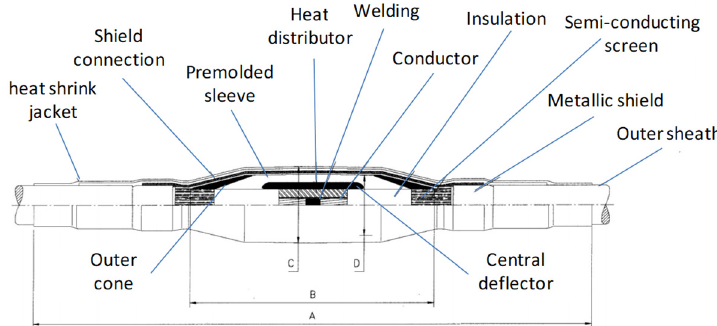
Figure 1. Scheme of the modelled joint with main approximate dimensions: length 800 mm, conductor radius 22.8 mm, insulation thickness 20 mm in the cable and 70 mm in the joint. Field distribution cones are present at both ends of the joint and a central deflector covers the welding. The cones and the deflector are composed of semiconductor material (semicon), i.e., a carbon black charged polymer. The semiconducting layer is also present on the conductor. In the model described here, the outer layer, which normally contains shielding layers, is simplified by using a 5 mm thick semicon layer ensuring electrical continuity, providing thermal resistance at the surface of the joint. The field distribution vestigated.